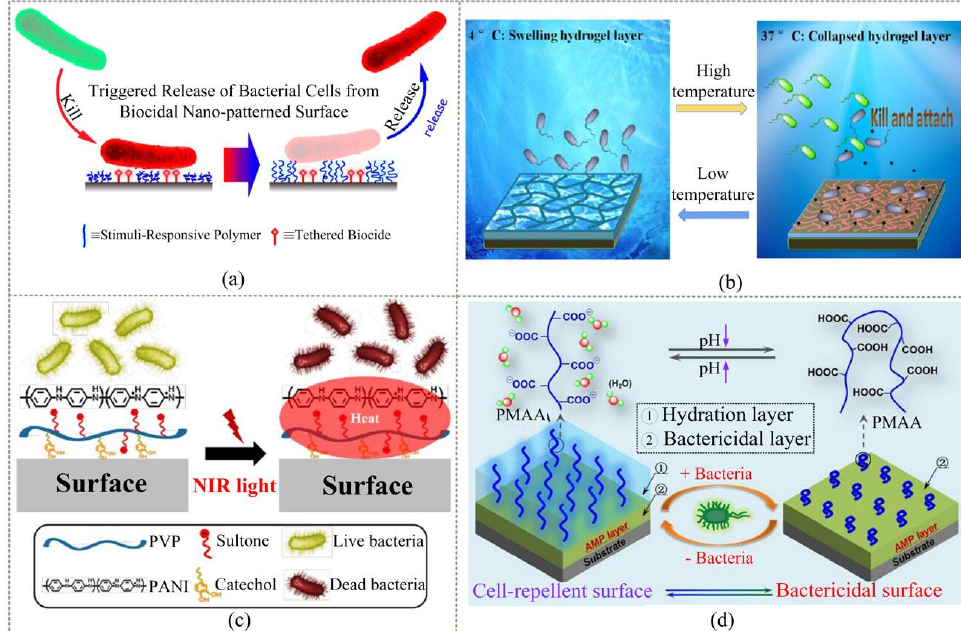
Figure 10. Bactericidal mechanisms of intelligent response antibacterial coatings: ( a ) based on tem- perature response [148]; ( b ) temperature change as the switch for antibacterial substances [149]; ( c ) based on NIR light response [150]; ( d ) based on pH response [151].